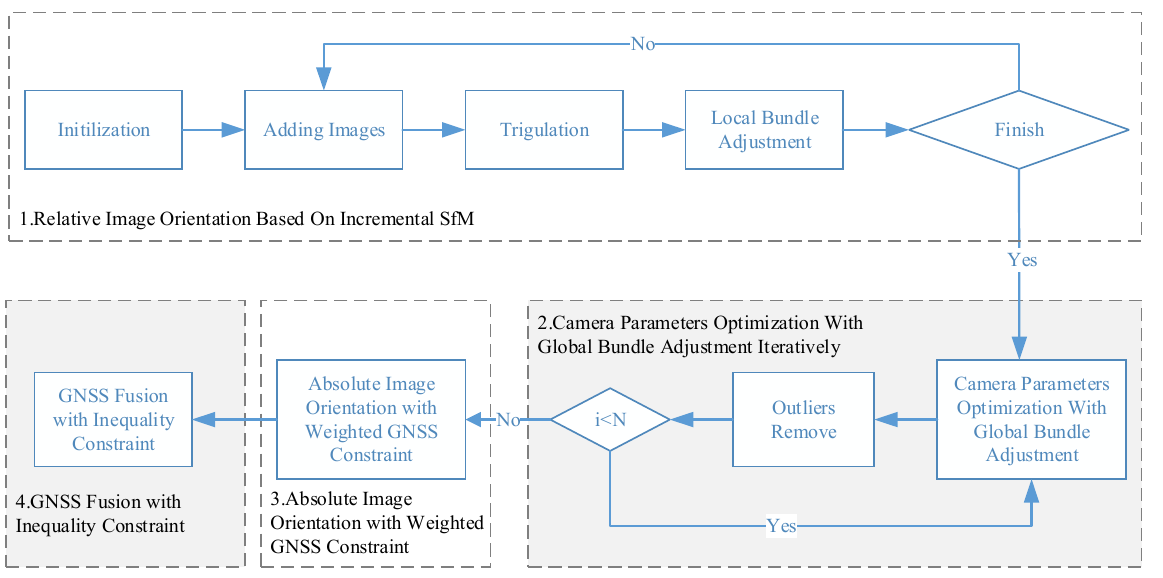
Figure 4. The camera self-calibration workflow for long corridor UAV images.